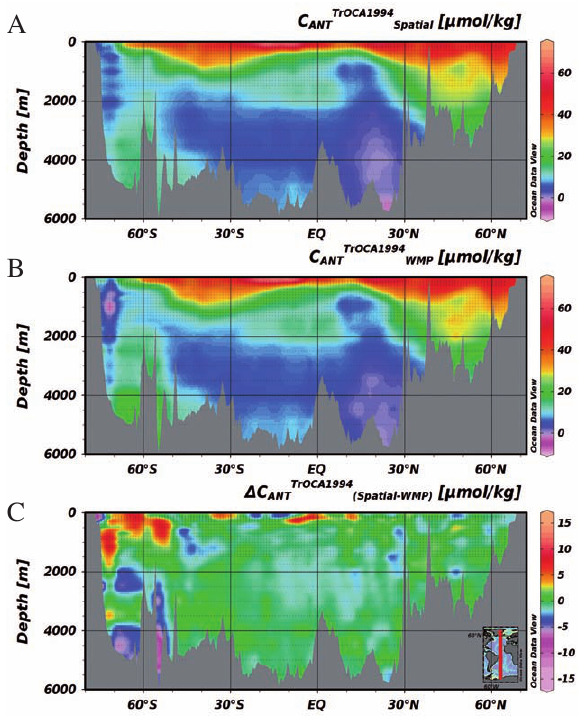
Fig . 7. – C (µmol kg -1 ) determined by the TrOCA method along ANT 28ºW using spatial interpolation (A) and WMP interpolation (B). Residuals between the two interpolations are shown (C) as spatially interpolated minus WMP interpolated.